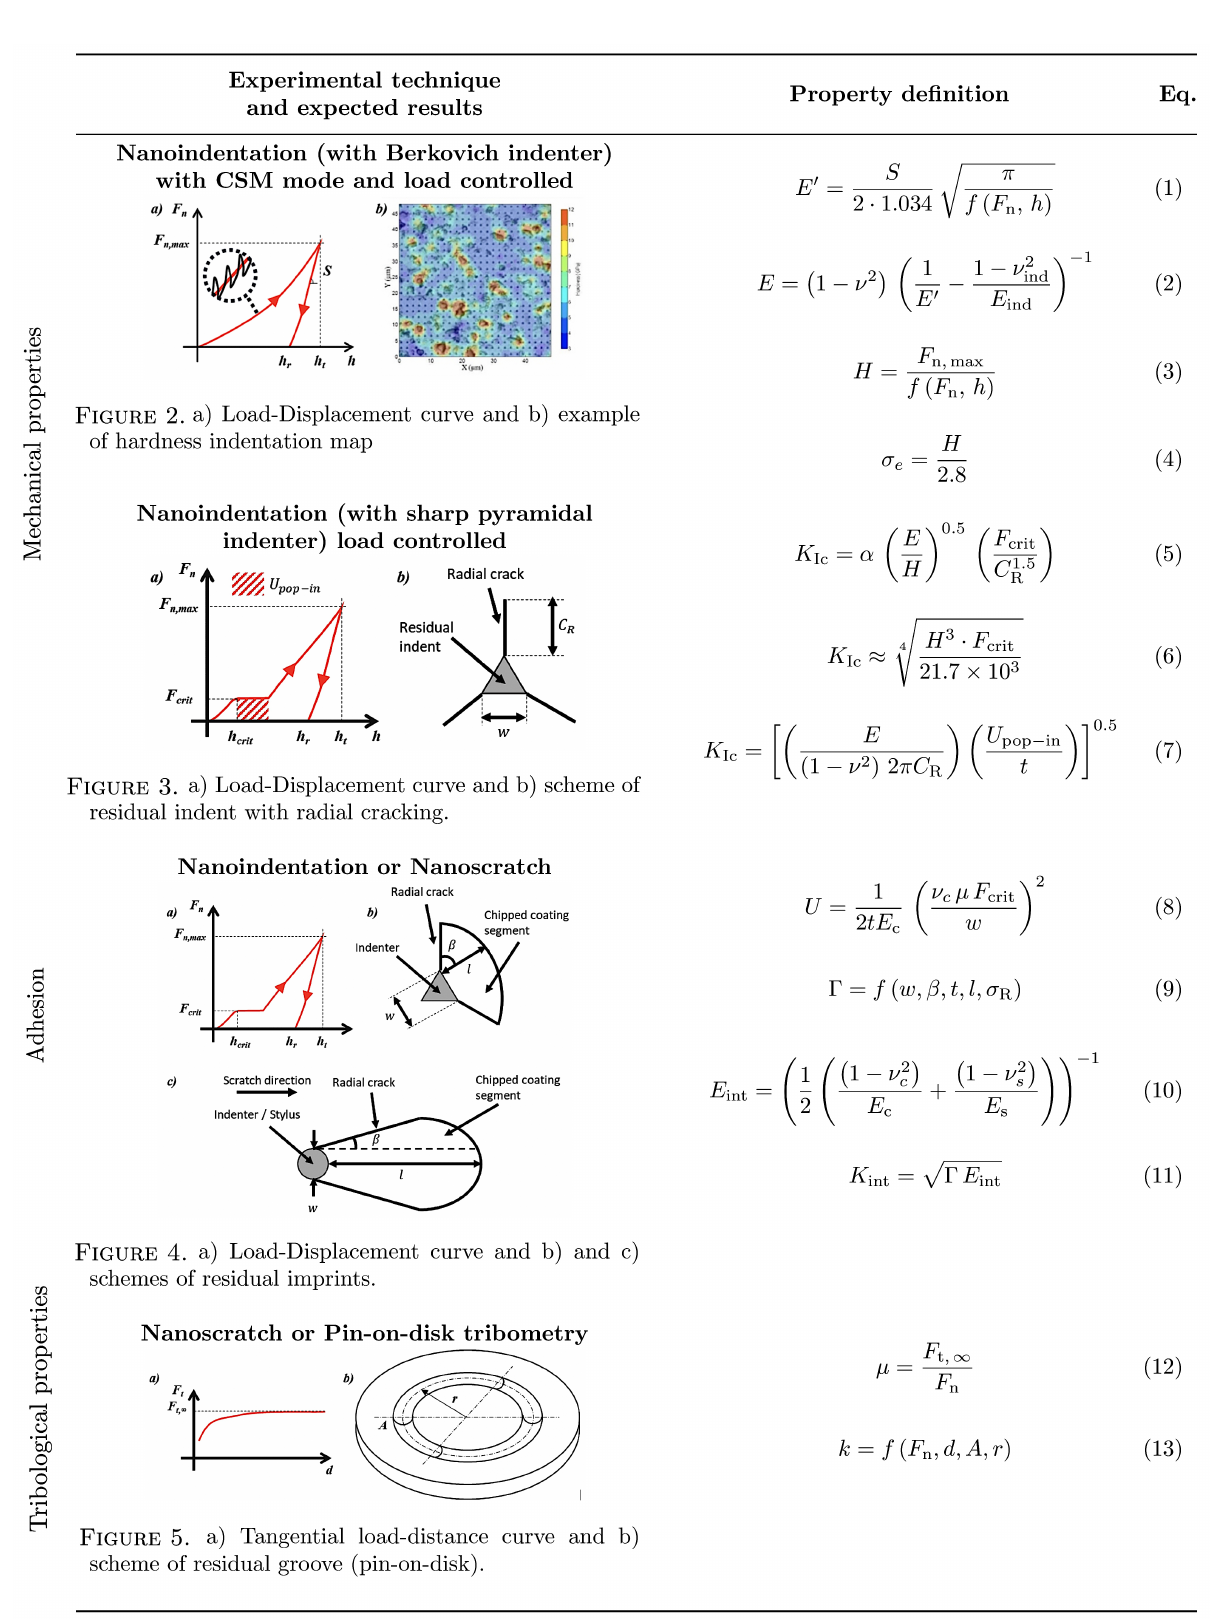
Table 1. Summary of nanomechanical experiments and expected results for mechanical properties, adhesion and tribological property calculations. CSM is for continuous stiffness